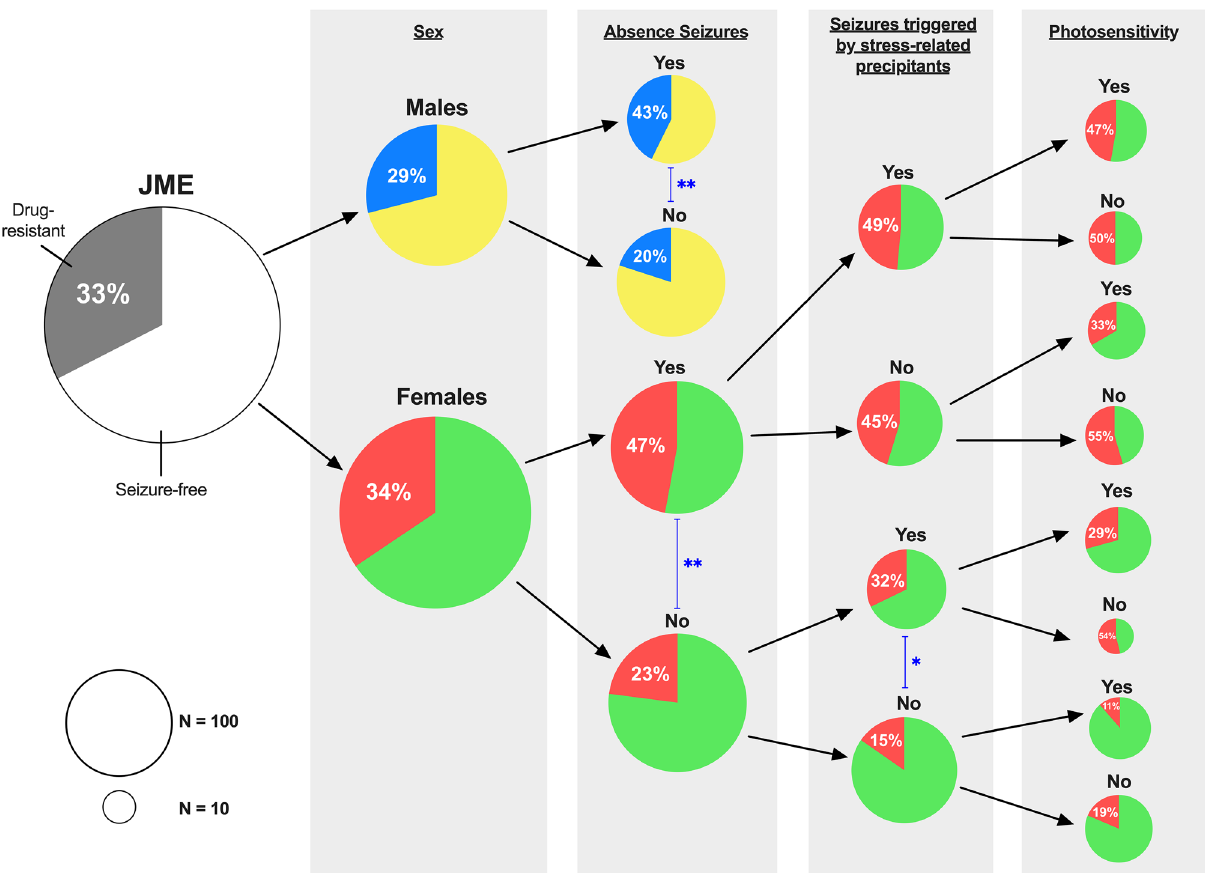
Figure 2. Differential rates of drug resistance in subgroups of JME. The right (white/green/yellow) segment of pie charts represent those seizure-free for over one year, and the left (grey/red/blue) segment represent those who are drug-resistant. Absence seizures moderate the effect of seizures triggered by stress precipitants in females, whereas photosensitivity (here defined as any response to photic stimulation during an EEG and/or reporting light/visual patterns as a trigger) is a protective factor for seizure control in all female strata. The area of the circle is proportional to the size of the subgroup in our cohort. ** p < 0.01 and * p < 0.05 in chi-squared tests.